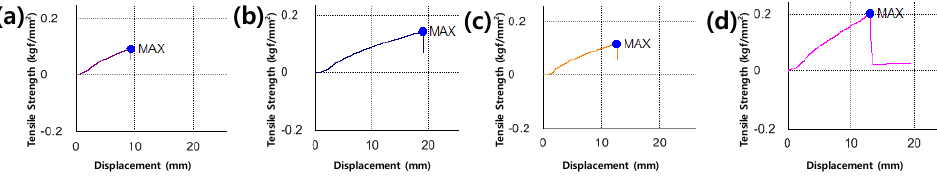
Figure 3. Tensile strength image of ( a ) ref sample, ( b ) Ce sample, ( c ) CeP10 sample and ( d ) CeP10_ISO1 sample.